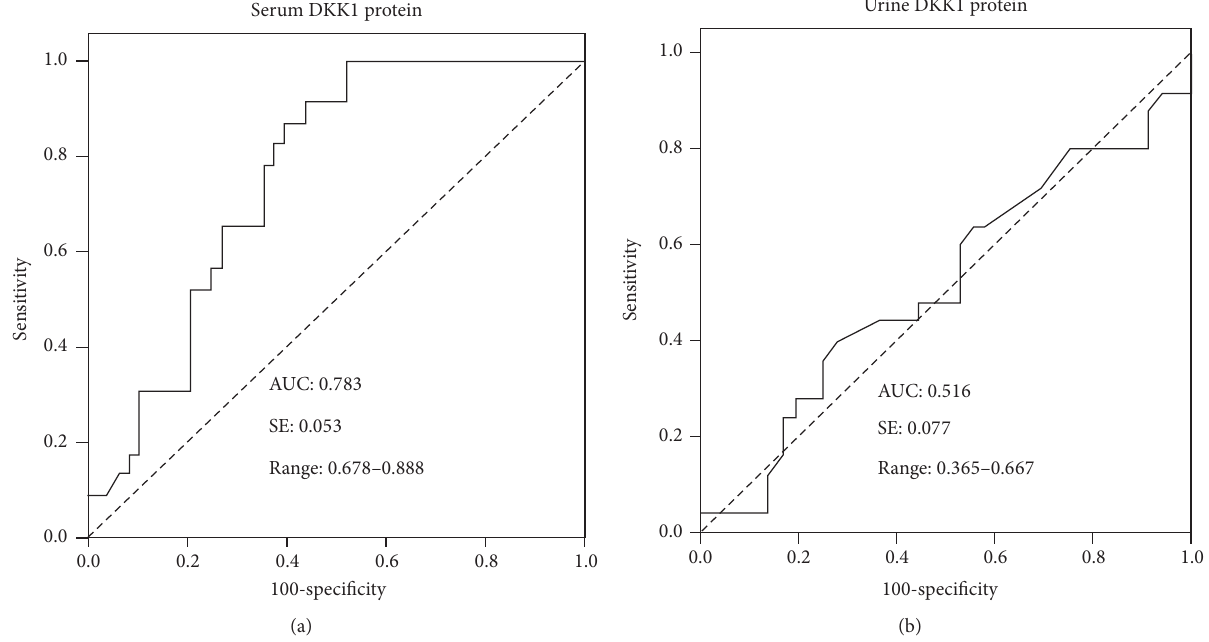
Figure 4: ROC curve for DKK-1 in active lupus nephritis. (a) ROC curve for serum DKK-1 in active lupus nephritis. (b) ROC curve for urine DKK-1 in active lupus